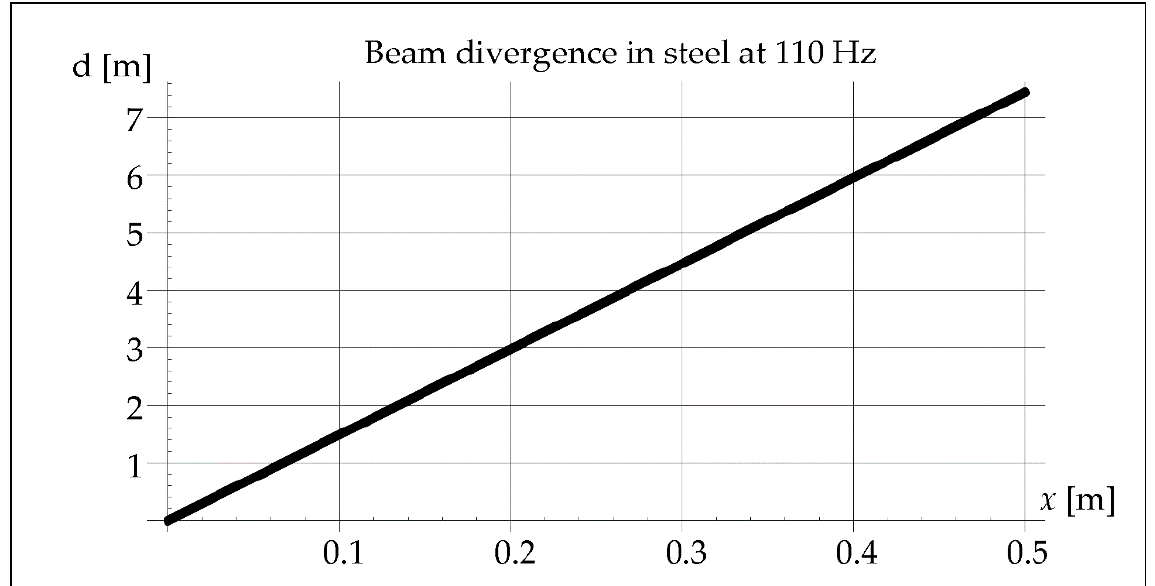
Figure 12. Beam divergence in steel at 110 Hz.